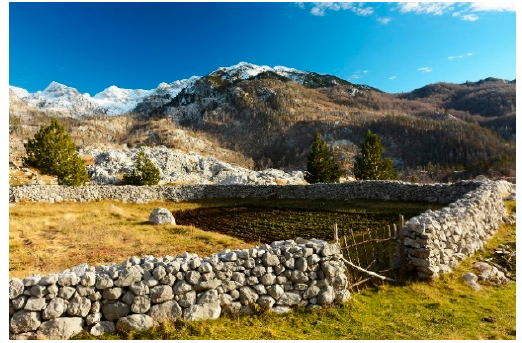
Figure 34. Torina turned into a potato crop – Kastrat, photo: I. Lakovi ć .